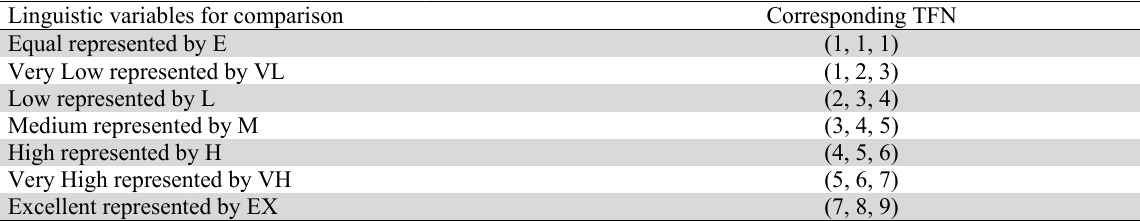
TFN for comparison of enablers in linguistic